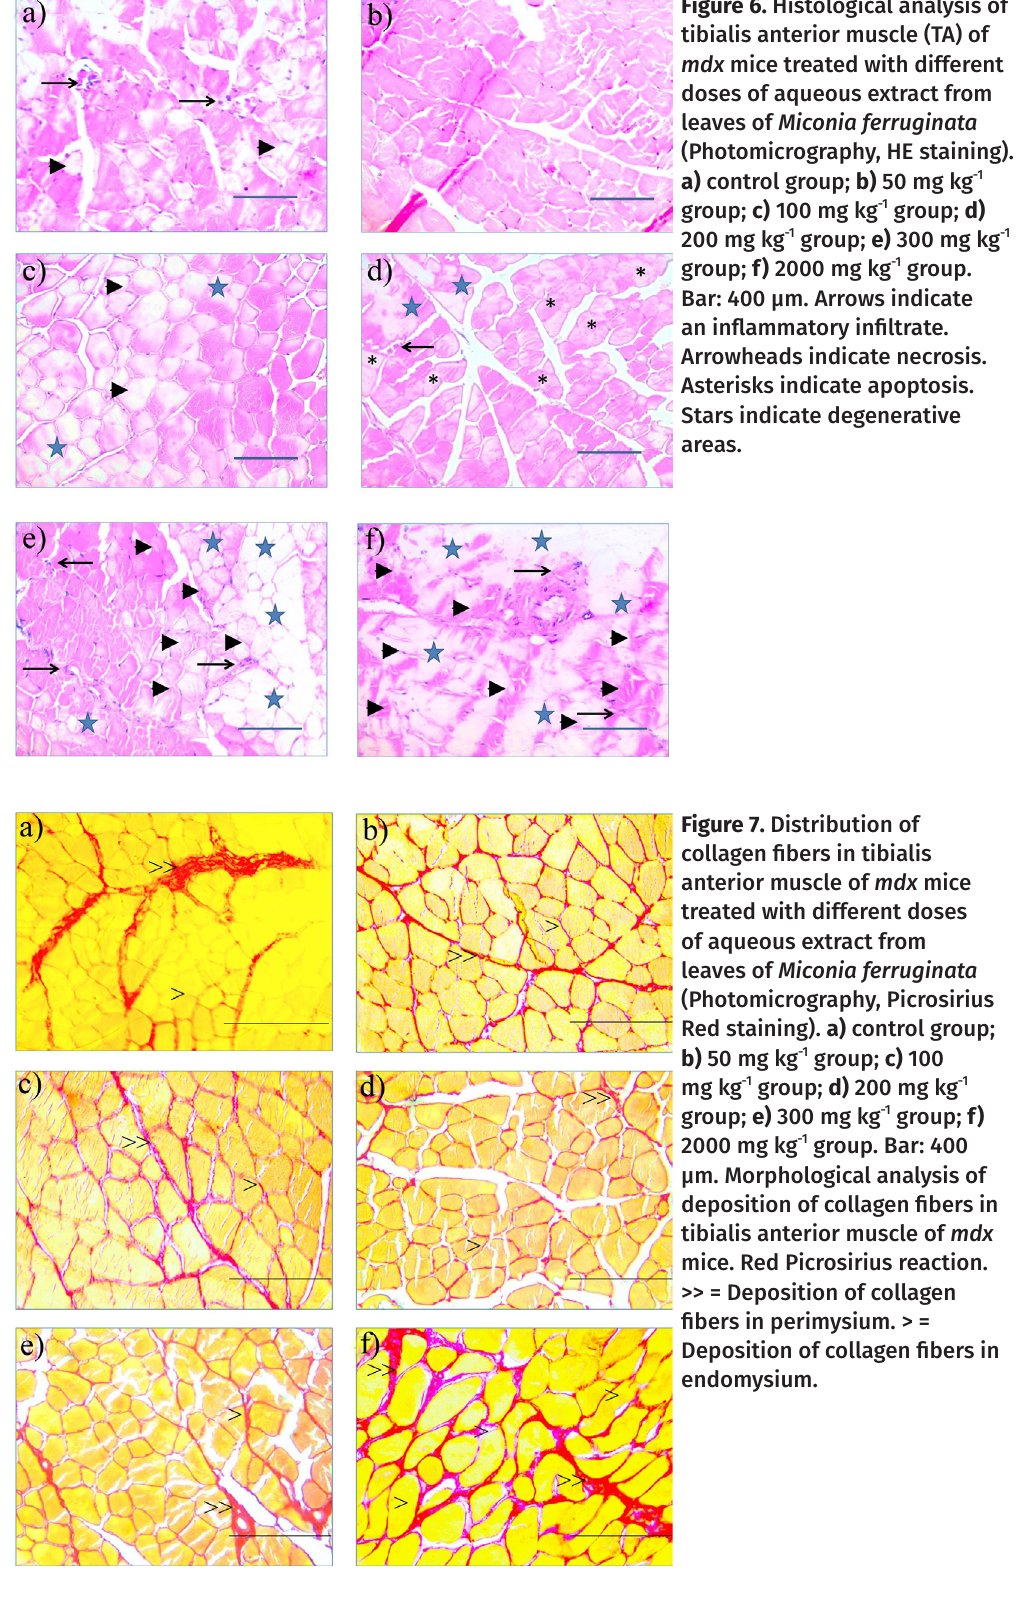
Figure 6. Histological analysis of tibialis anterior muscle (TA) of mdx mice treated with different doses of aqueous extract from leaves of Miconia ferruginata (Photomicrography, HE staining). a) control group; b) 50 mg kg -1